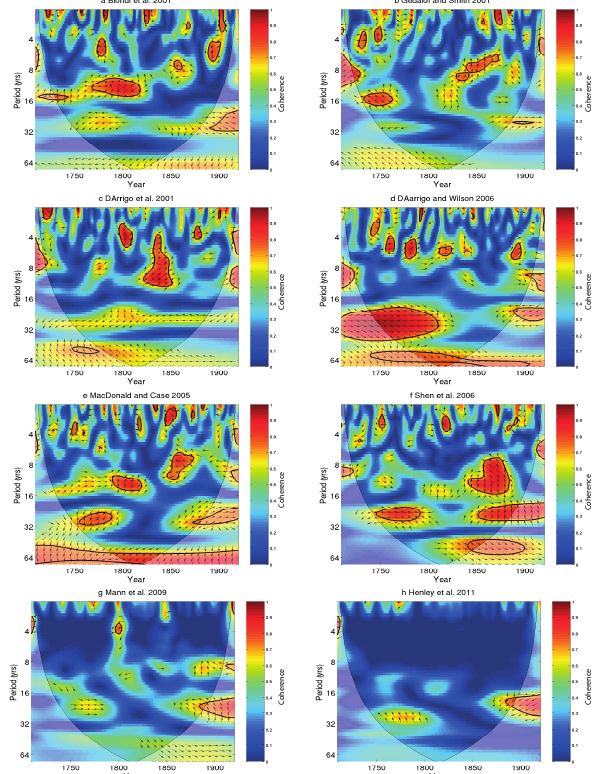
Fig. 4. Cross-wavelet coherence analysis of MASB G/B 1709–1920 data (as represented in Fig. 2b, with the centennial scale variance re- moved.) with a variety of reconstructed PDO indices, including the (a) Biondi et al. (2001), (b) Gedalof and Smith (2001), (c) D’Arrigo et al. (2001), (d) D’Arrigo and Wilson (2006), (e) MacDonald and Case (2005), (f) Shen et al. (2006), (g) Mann et al. (2009) and (h) Henley et al. (2011) records, as shown in Fig. 3. The 5% signifi- cance level against red noise is shown as a thick contour. Phases are indicated as arrows, where directing right represents an in phase, and a clockwise direction indicates a lead of the